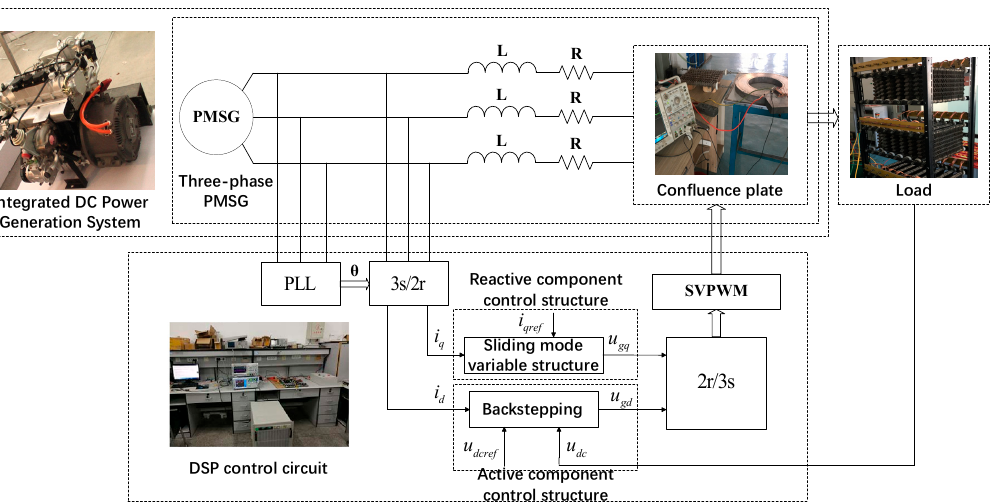
Figure 15. Low-voltage and high-current DC voltage control system.